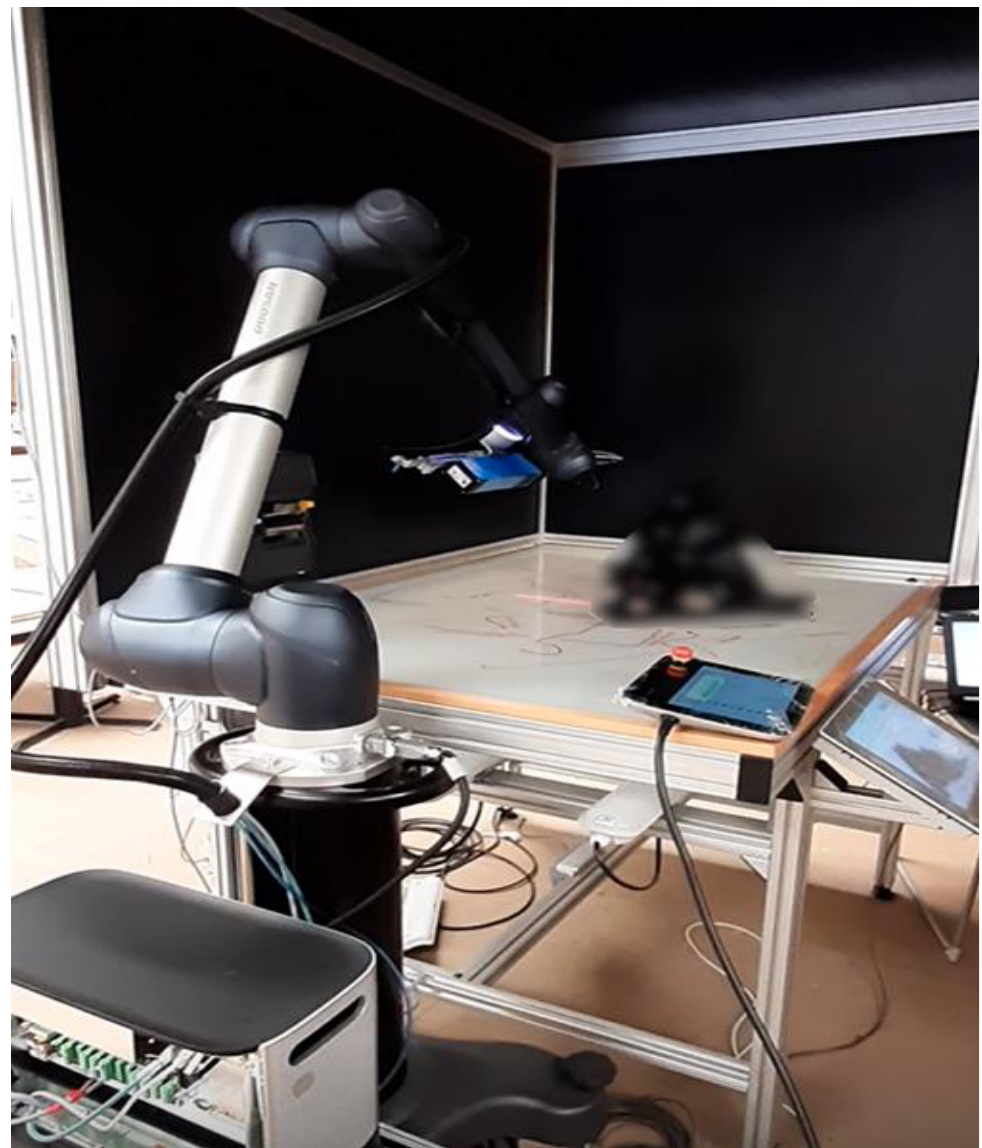
Figure 2. Industrial prototype for quality inspection.